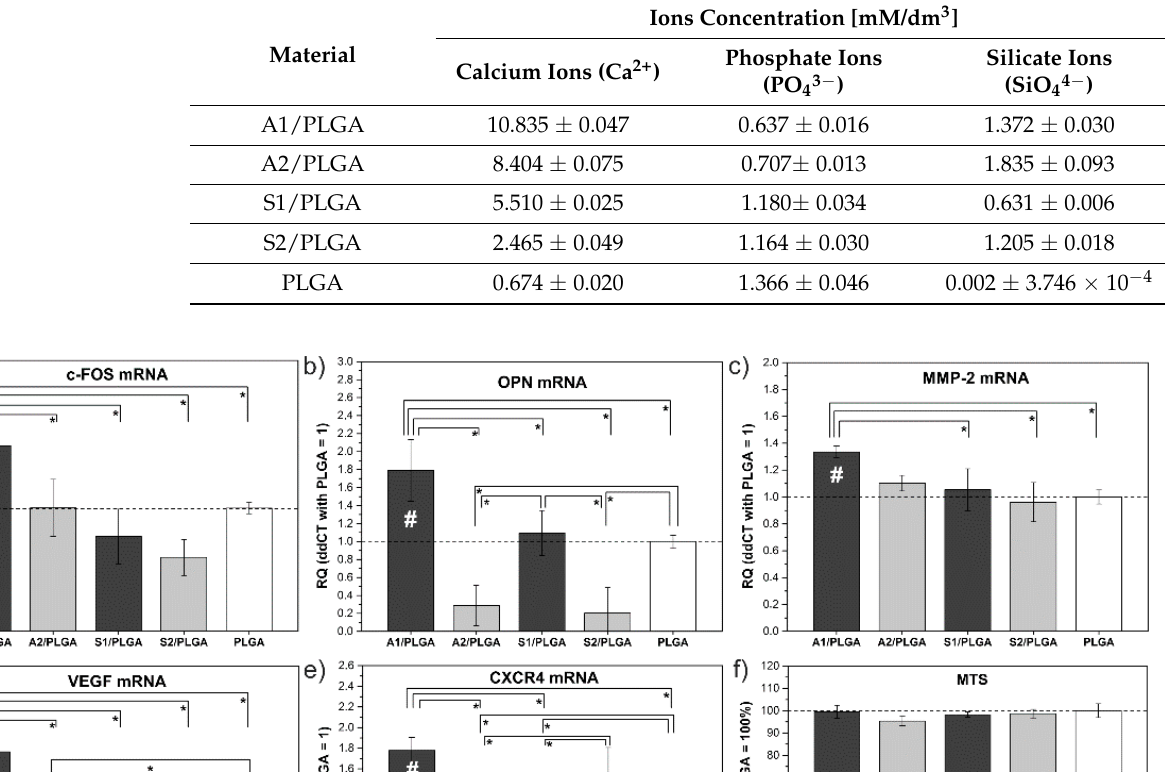
Table 1. Ca, Si, and P concentrations in the culture medium after 24-h soaking of SBG/PLGA composites and PLGA control. Adapted from Ref. [7].